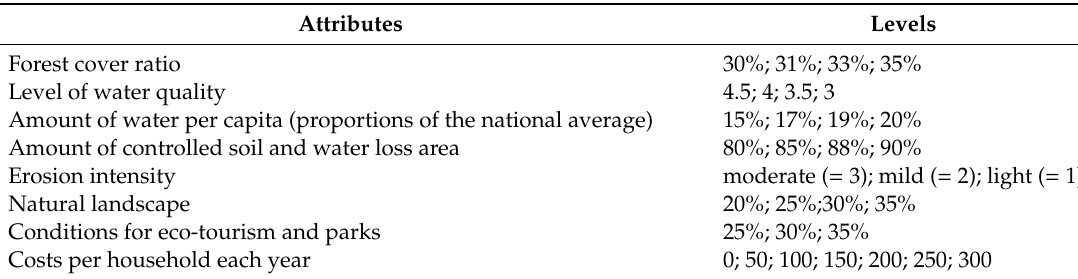
Table 1. Attributes and levels in Wei River